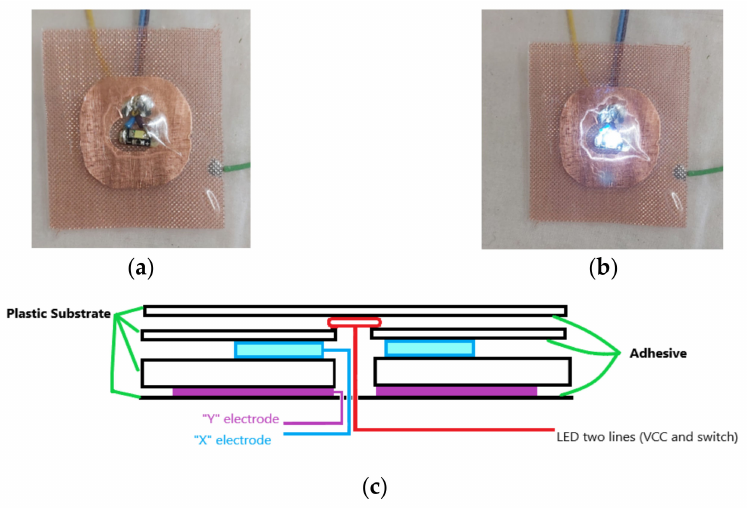
Figure 7. Capacitive touch sensor (Capacitive Touch Sensor 1—CTS1) with integrated LED (items 7,8,9,10 in Figure 3b) showing ( a ) LED not lighted, ( b ) LED lighted, and ( c ) construction principle.